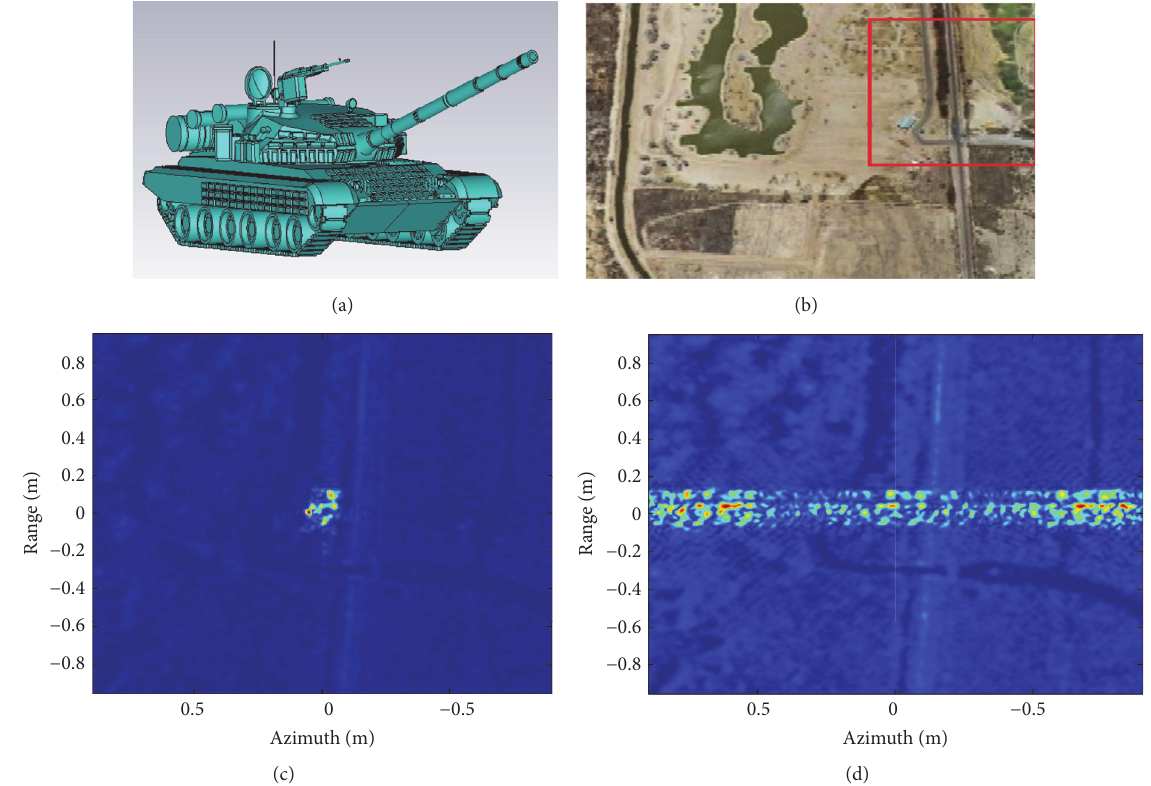
Figure 9: Simulated THz-SAR images of the tank model when stationary and vibrating, respectively. (a) Tank model; (b) Isleta Lake in New Mexico used as the background; (c) image of stationary tank model; (d) image of vibrating tank model.